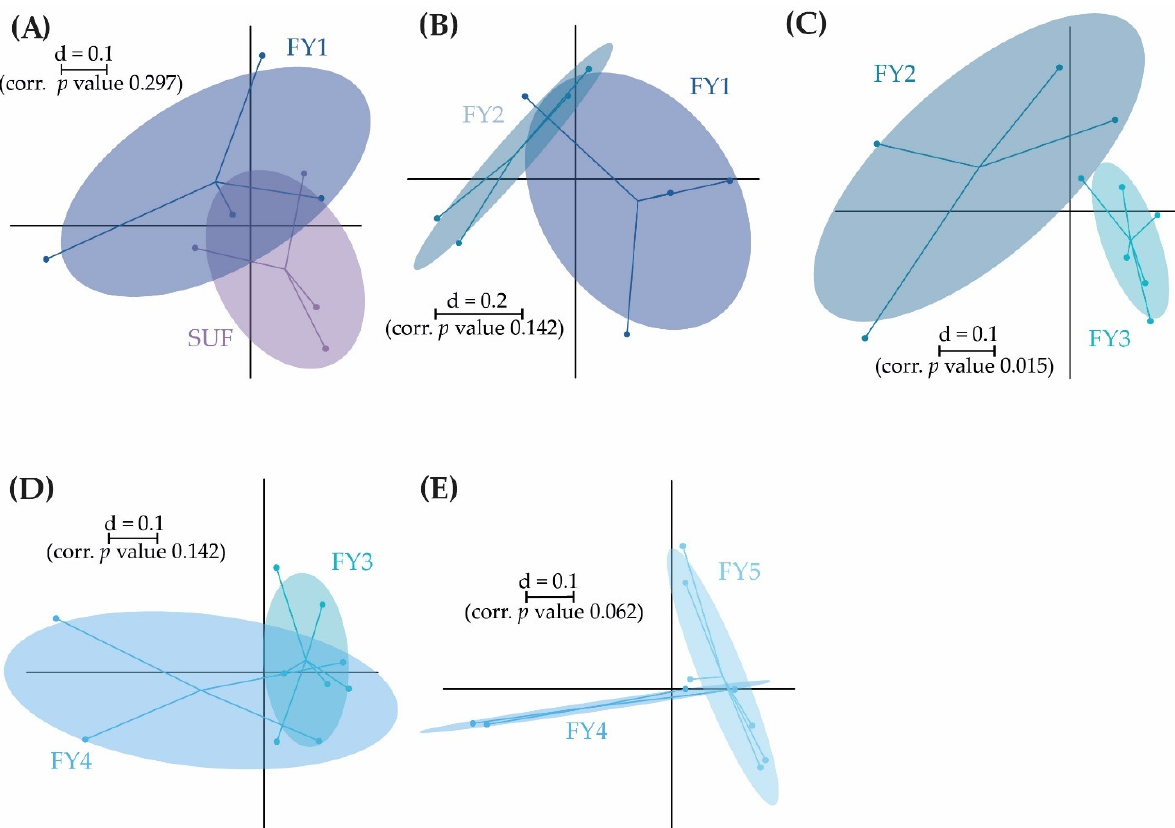
Figure 10. Pairwise β -diversity of the fry stages and SUF displayed as a multidimensional-scaling (MDS) plots. The scale is an indicator for the differences in the taxonomic makeup of microbiota between samples ( β -diversity) based on generalized UniFrac distances (d = 0.1 marks a 10% difference). Pairwise β -diversity between SUF and FY1 ( A ); FY1 and FY2 ( B ); FY2 and FY3 ( C ); FY3 and FY4 ( D ); FY4 and FY5 ( E ). SUF, swim-up fry; FY1, fry 69 dpf; FY2, fry 74 dpf; FY3, fry 82 dpf; FY4, fry 88 dpf; FY5, fry 95 dpf; dpf, days post fertilization.